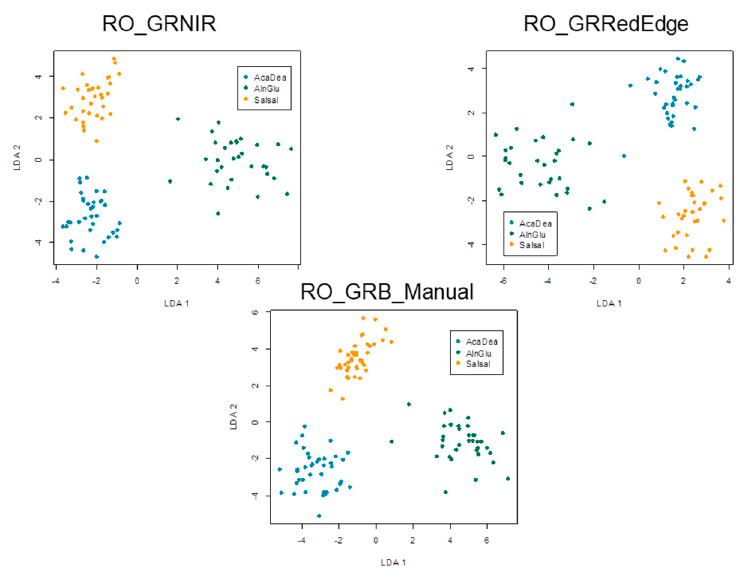
Figure 5. Training objects in the bidimensional space of Linear Discriminant using the three image-band combination. Yellow dots represent Salix salviifolia , blue dots Acacia dealbata and green dots Alnus glutinosa objects. RO_GRNIR—riparian objects automatically obtained during the segmentation process with the Green-Red-NIR image-composite band; RO_GRRedEdge—riparian objects automatically obtained during the segmentation process with the Green-Red-RedEdge image-composite band. RO_Manual—riparian objects manually digitalized with the RGB image-composite band.